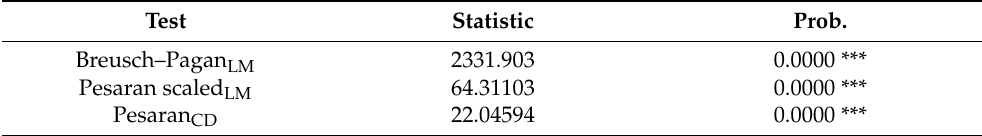
Table 4. Cross-sectional dependence test results. Test Statistic